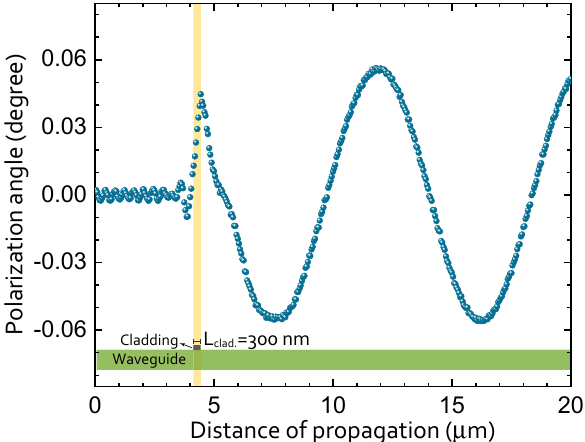
Figure 3: Optical simulation (FDTD), showing the polarization evolution of the initially purely TE-polarized input light, as it propagates in the rectangular waveguide section cladded with the memory material. The polarization angle refers to the rotation caused by the MOKE. The region with the magnetic cladding (memory) is shown with the vertical highlighted region. The stack order and the length of the cladding are Ta4/Pt2/Co1/Pt2/Co1/Pt2 (numbers in nm) and 300 nm, respectively. A conformal meshing of 2 nm is used.